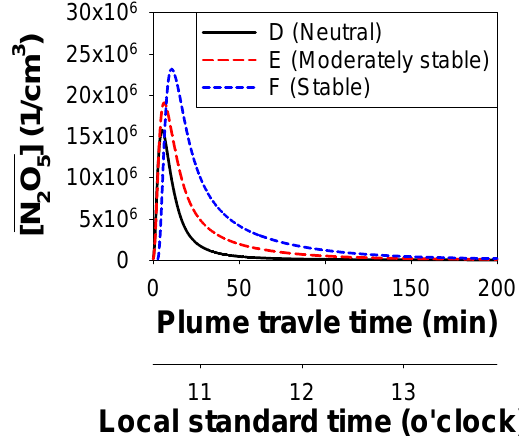
Fig. 10. Possible build-up of dinitrogen pentoxide (N 2 O 5 ) radicals inside the ITCT 2K2 ship plume with three MBL stability classes: (i) neutral (D), (ii) moderately stable (E), and (iii) stable (F). The ship plumes are released at 10:30a.m.